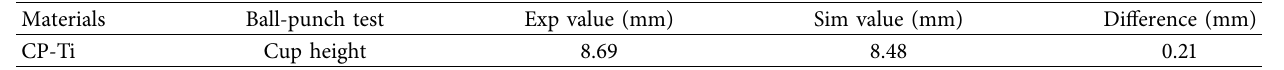
Figure 10: Simulated results indicating the stress distribution over the FLD zones recorded after the ball-punch test. Table 4: Cupping test results from experiments and